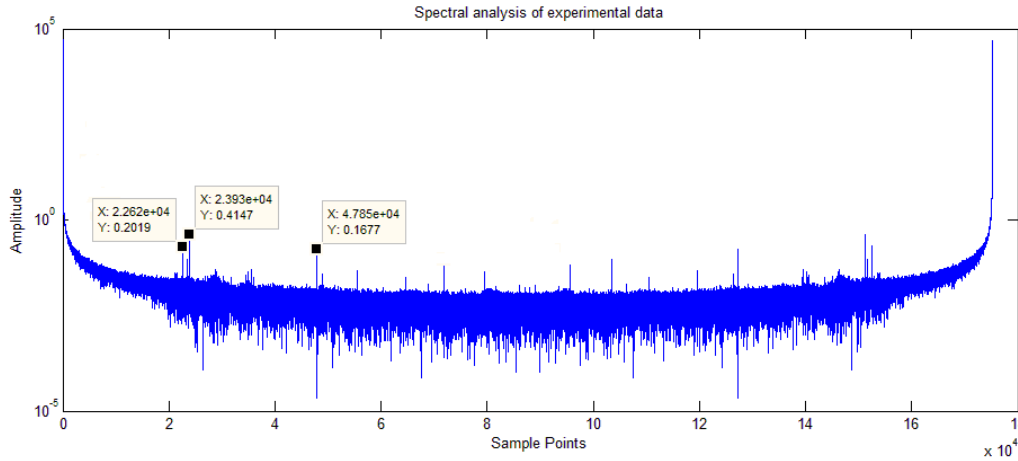
Figure 23. Spectrum analysis of experimental data.